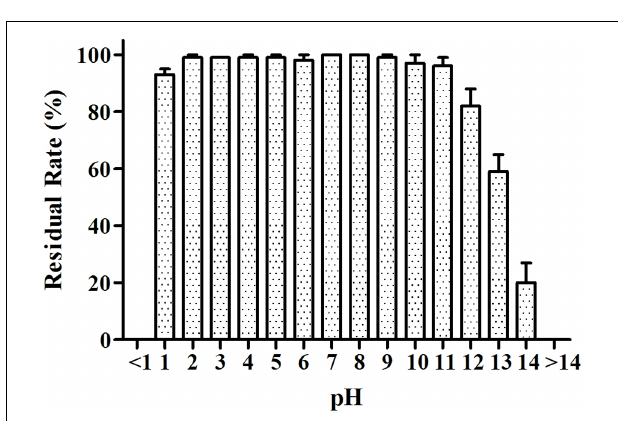
FIGURE 8 | pH resistance test. The activities of lipopeptides retained above 90% from pH 1 to pH 11.